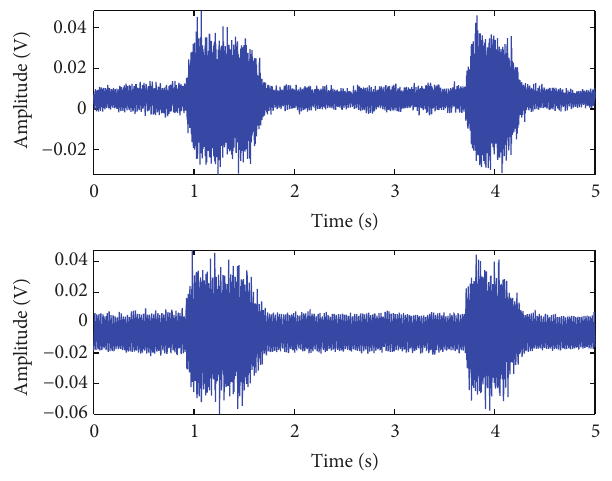
Figure 3: Example microphone signals for a phone ringing (sound of daily life—higher energy segments) with the radio on (back- ground noise—lower energy